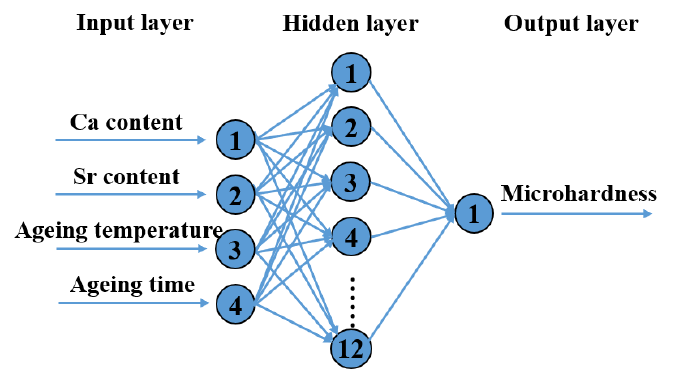
Figure 2. The architecture of the three-layered BP neural network in the present study.